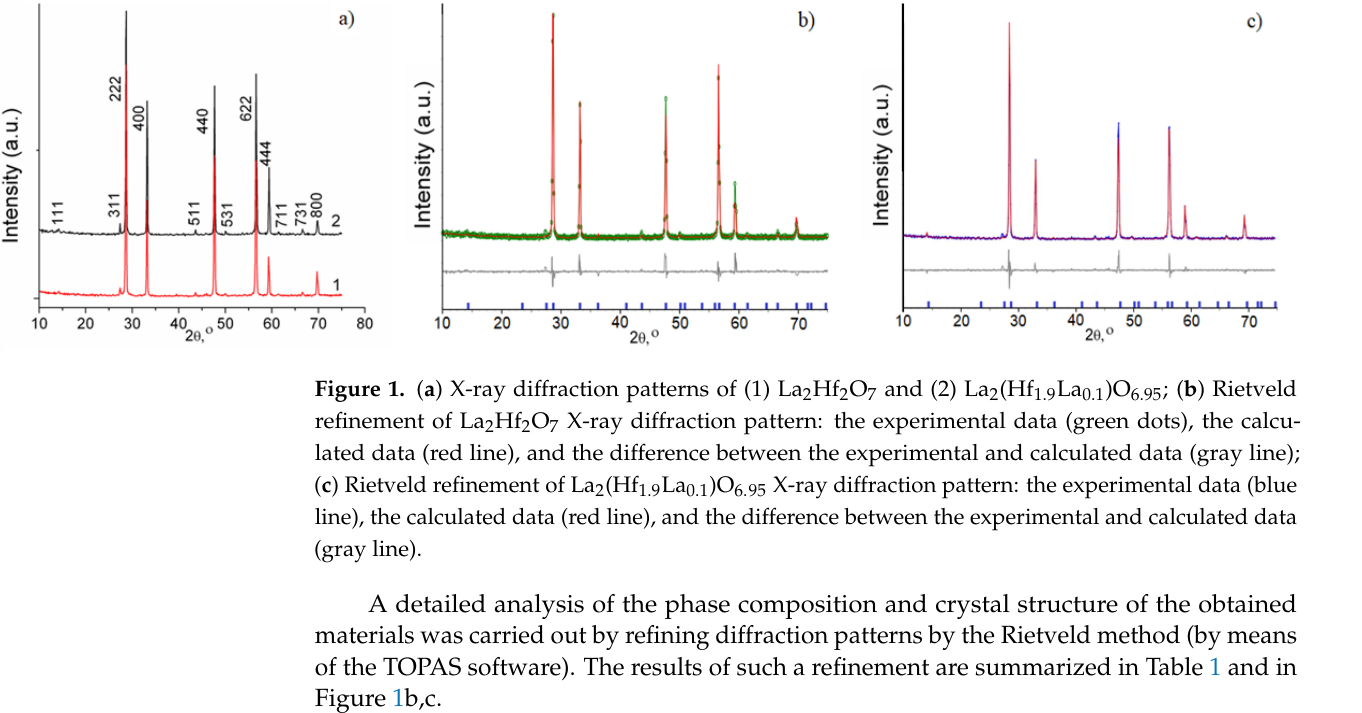
Table 1. Rietveld refinement of positions for La 2 (Hf 2 − x La x )O 7 − x /2 ( x = 0, 0.1) (sp.gr. F d- 3 m ) at T = 300 K.